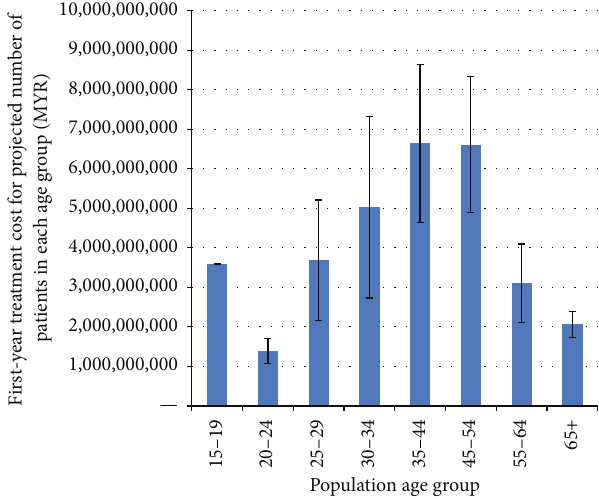
Figure 4: Economic burden of periodontitis by treatment mix. I: nonsurgical only (NSPT), II: NSPT and periodontal surgery (PS), III: NSPT and nonsurgical rehabilitative therapy (NSRT), IV: NSPT, PS, and